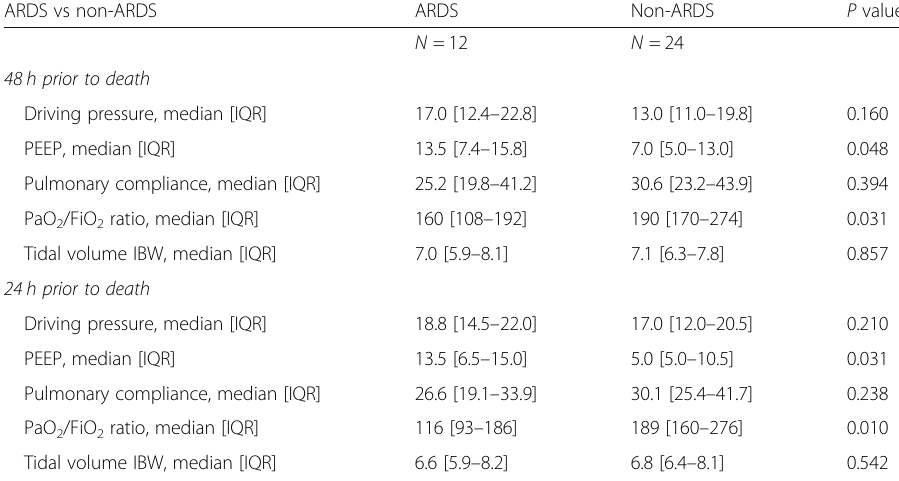
Table 2 Ventilation characteristics